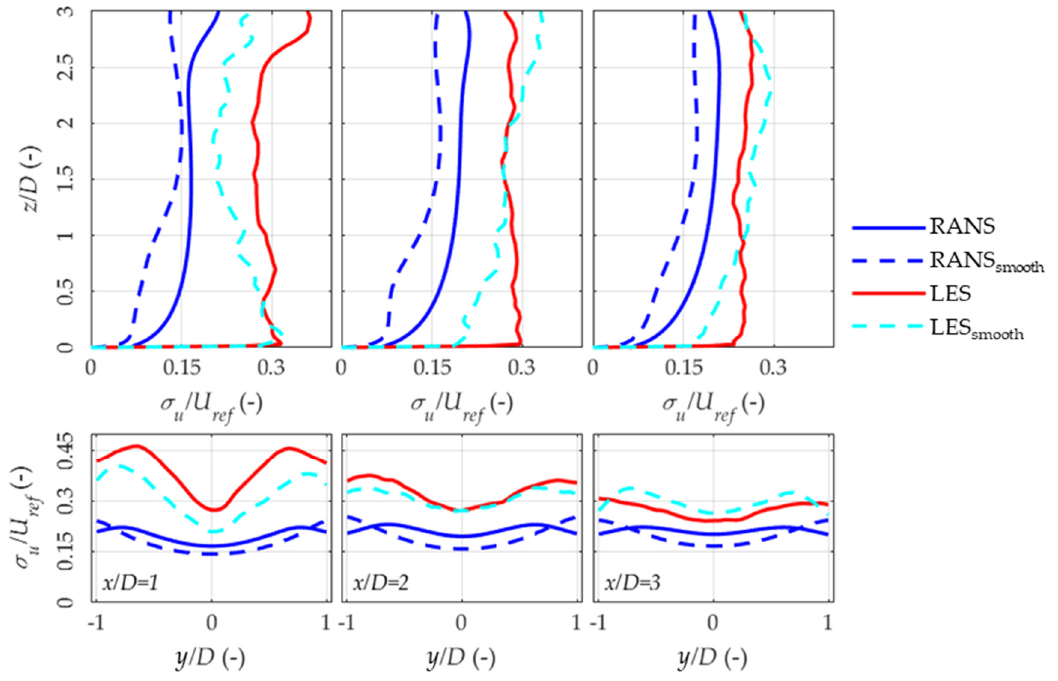
Figure 19. Prediction of the standard deviation of the longitudinal wind speed distribution in the wake region. Profiles refer to three distances from the downstream side of the building, namely, x / D = 1, 2, and 3.